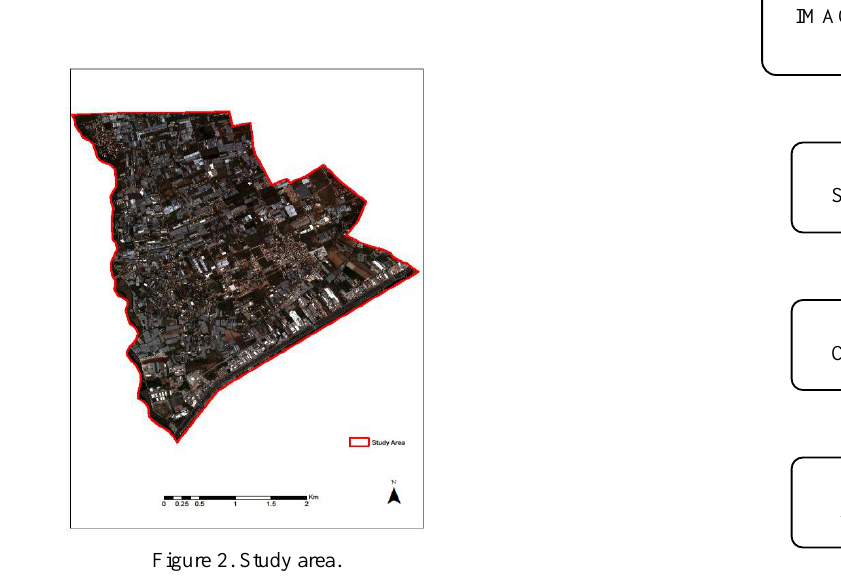
Figure 4. Flowchart of the object-based image analysis.